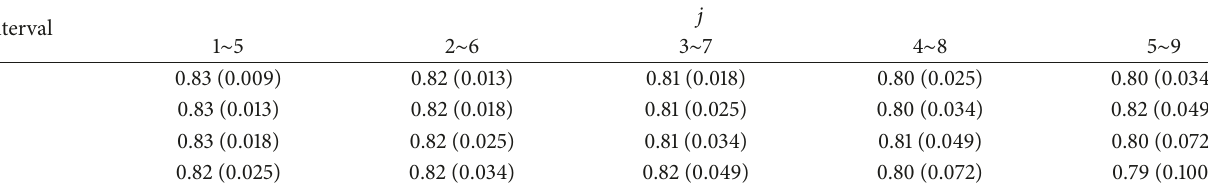
Table 3: Simulation data analysis for H ( H = 0.8, data length = 180000).